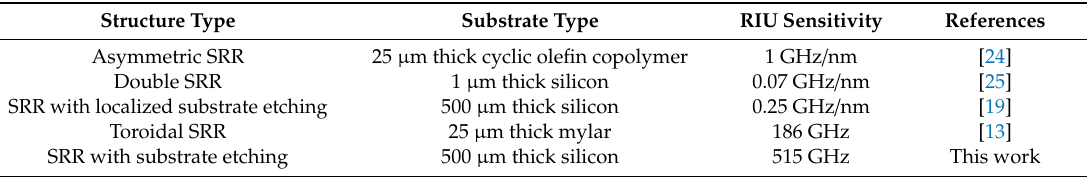
Table 1. Performance of recently demonstrated THz metamaterial dielectric sensors. RIU sensitivities are presented in two units. GHz / nm for the sensors that are focusing on the surface sensing near the metamaterials where the sensitivity depends on the analyte thickness, and GHz for the sensors using the saturated resonant frequency shift for its sensing where the sensitivity is independent on the analyte